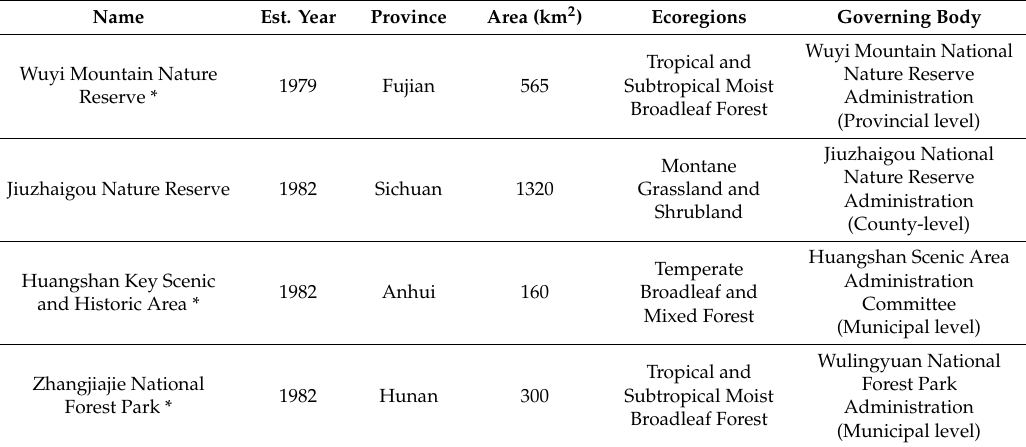
Table 1. Profile of ten conventional protected areas in China.